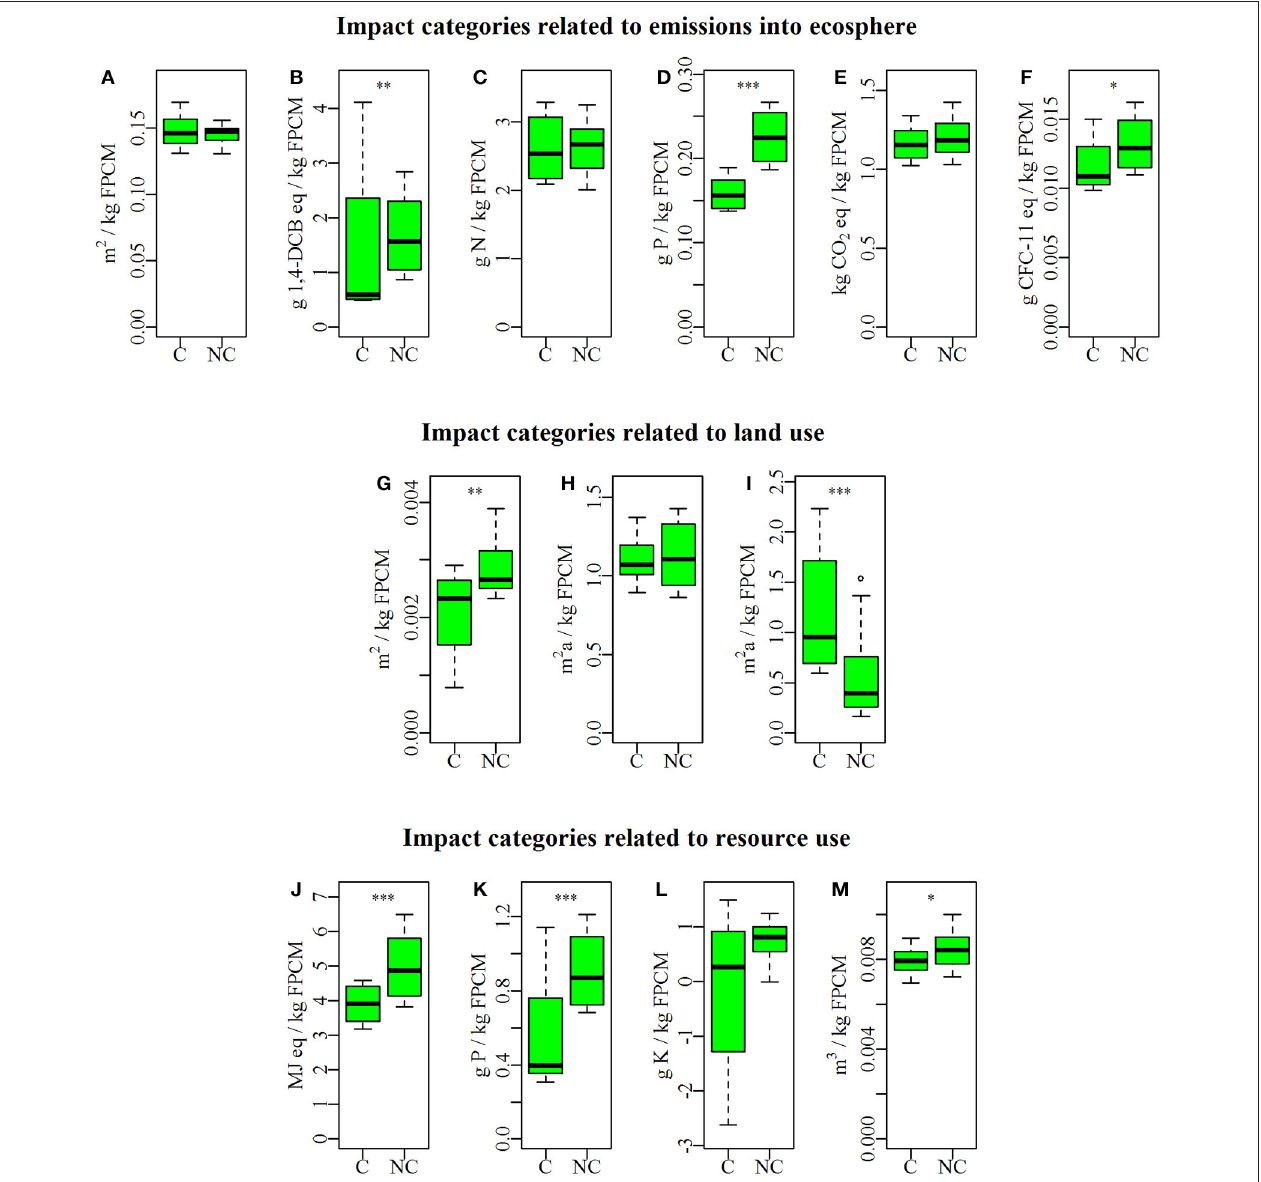
FIGURE 6 | Environmental impacts per kg of fat- and protein-corrected milk (FPCM) from collaborative (C; n = 16) and non-collaborative (NC; n = 16) production systems for impact categories (A) acidification, (B) terrestrial ecotoxicity, (C) eutrophication due to N, (D) eutrophication due to P, (E) global warming potential, (F) ozone depletion potential, (G) deforestation, (H) land competition, (I) alpine summer-pasture land use, (J) non-renewable energy demand, (K) resource use, P extraction, (L) resource use, K extraction, and (M) water use. Whiskers indicate 1.5 times the standard deviation, and asterisks indicate significance level (* p < 0.05, ** p < 0.01, *** p <